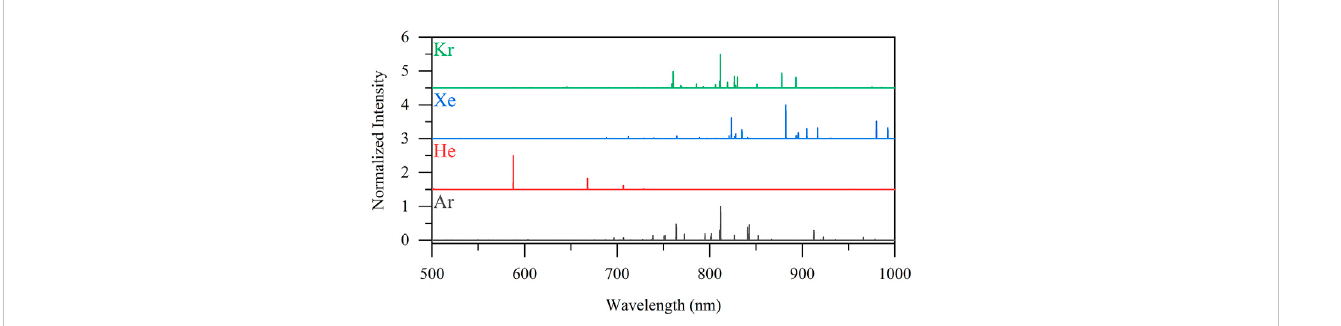
FIGURE 5 Calculated emission spectra of Kr, Xe, He, and Ar at a plasma temperature of 1 eV and electron number of 10 17 cm − 3 . The spectral intensities have been normalized (0 – 1) to their maximum intensity for comparison purposes.